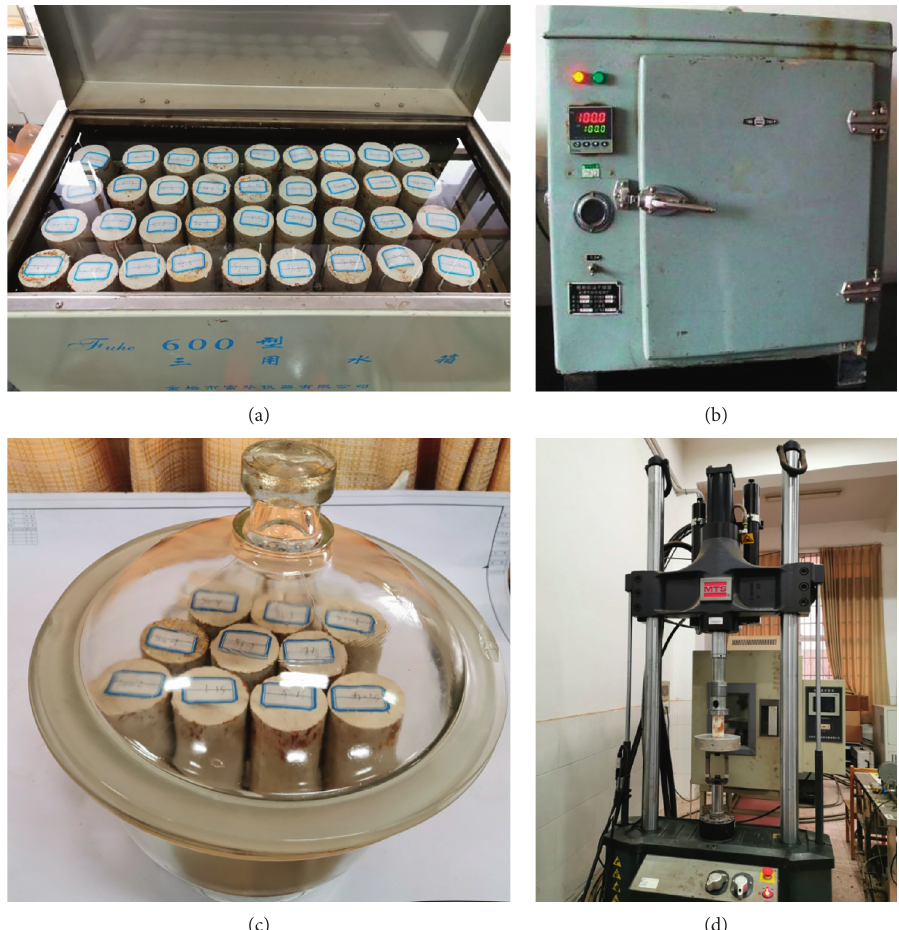
Figure 2: Test equipment: (a) three tanks; (b) electric constant temperature drying oven; (c) glass dryer; (d) MTS-810 electrohydraulic servo system testing